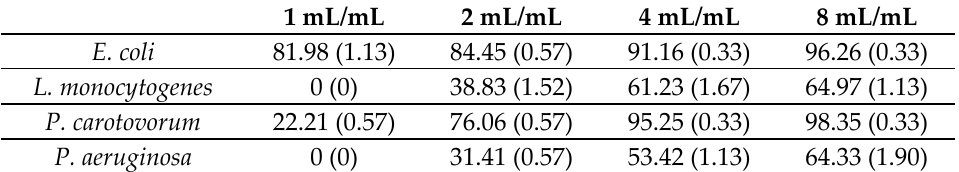
Table 3. Metabolic activity exhibited by the cells present within the bacterial biofilms in the presence of different volumes of O. ficus indica seeds oil. Results are reported as percent of inhibition respect to the control (% = 0). They are the mean (± SD) of three